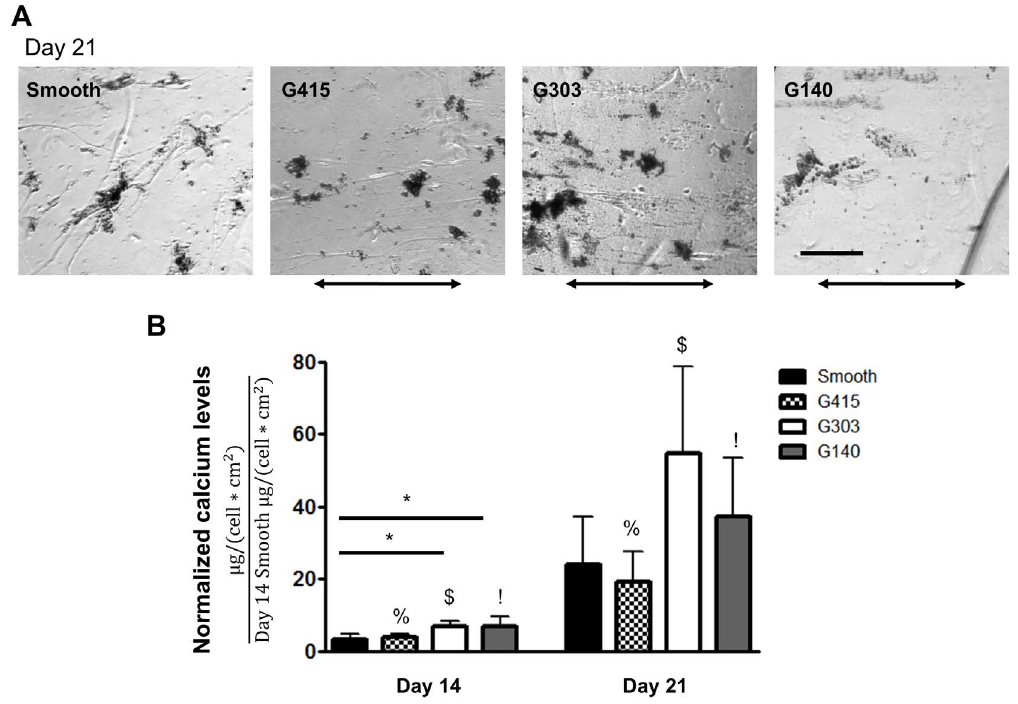
Figure 7. Calcium deposition was minimally influenced on nanotopgraphy. (A) Representative phase microscopy images illustrating mineral formed on PMMA films after MSCs were grown for 21 days in osteogenic mineralization media (OBM). Arrows indicate the direction of the underlying topography. Scale represents 200 m m. (B) Quantification of total calcium levels showed that G303 and G140 PMMA nanotopographic substrates supported slightly higher levels of calcium deposition on day 14 (* p , 0.05). However, there were no significant differences after 21 days (n=3). Symbols %, $ and ! all indicate significant differences (* p , 0.05) between day 14 and day 21 time points for the respective conditions.